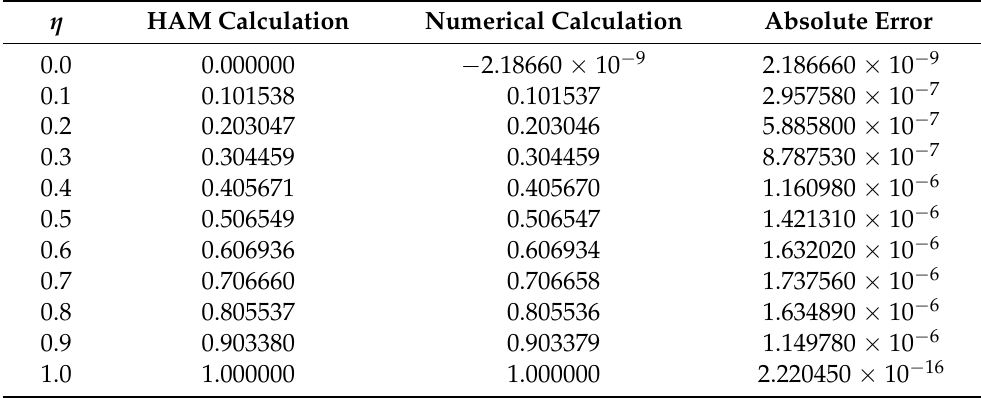
Table 5. Comparison between the analytical (HAM) and numerical results for θ ( η )